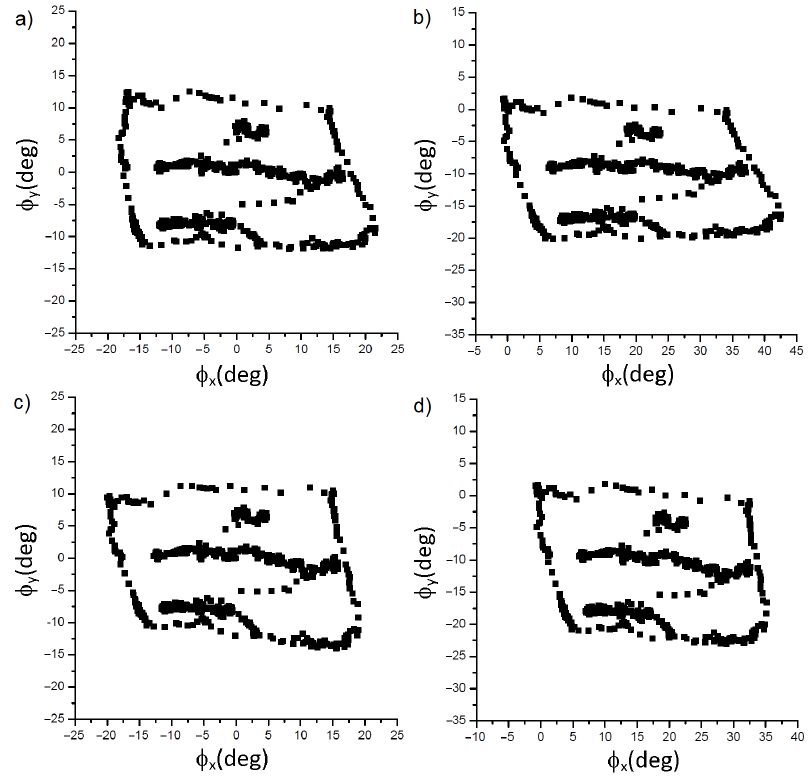
Figure 2. Gaze trajectories reconstructed on the basis of the approach described in Section 3.2. The subject was sitting about 110 cm away from a monitor, whose frame is 40 cm × 71.5 cm in size. He was requested to read a three-line text and then to follow the monitor frame (see also Figure 5). The upper plots ( a , b ) are obtained using R = R y R x , while the lower ones ( c , d ) are obtained with R = R x R y . The front sight direction (0,0) is not known and is in turn assigned to a central point of the screen (left plots, a , c ), or to the upper-left corner (right plots, b , d ). The small displacements of the trajectory are well tracked in all the cases, but evident image distortions occur over the large distances, i.e., when large rotations are involved. This kind of distortion arises independently on the assignment of the front-sight